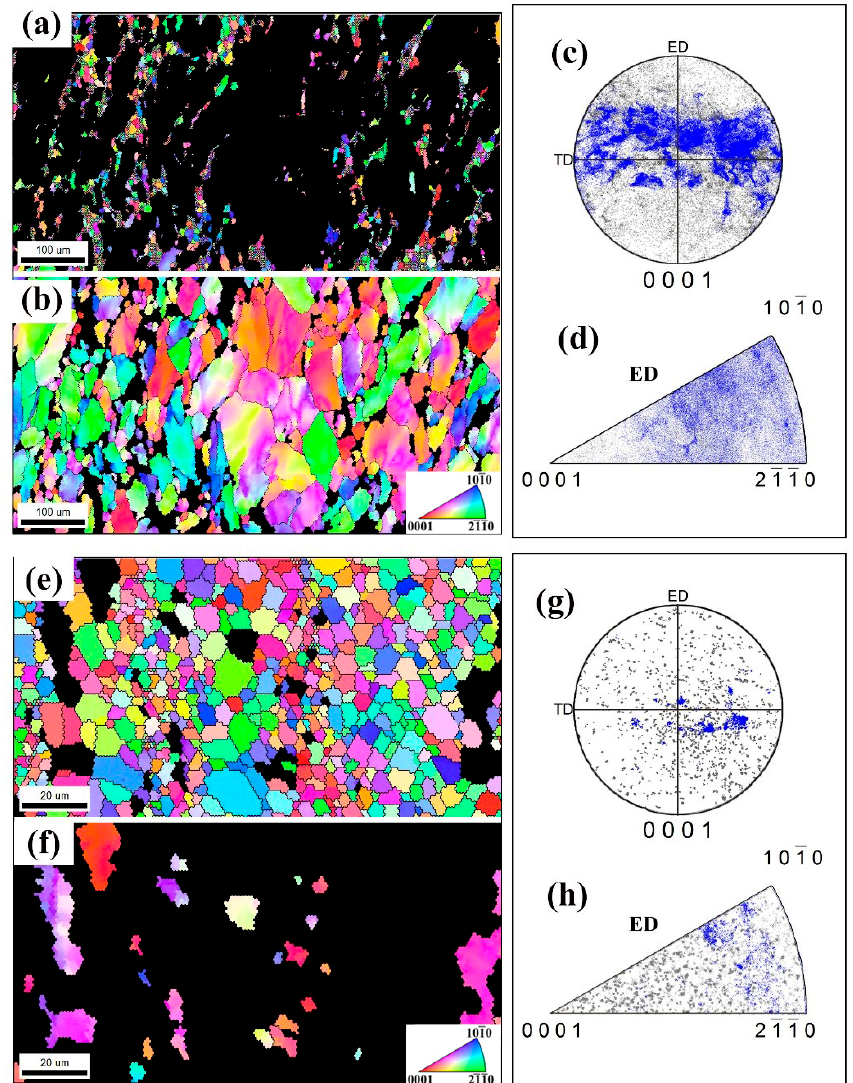
Figure 8. Inverse pole figure (IPF) coloring maps of DRXed ( a , e ) and unDRXed ( b , f ) grains after one-pass ( a , b ) and three-passes ( e , f ) deformation, and corresponding (0001) PF ( c , g ) and IPF ( d , h ).